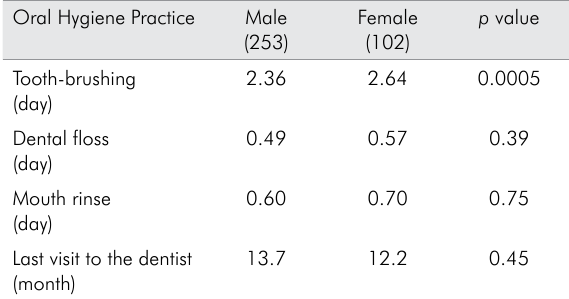
Table 2. Comparison of mean frequency of oral hygiene practices between genders.